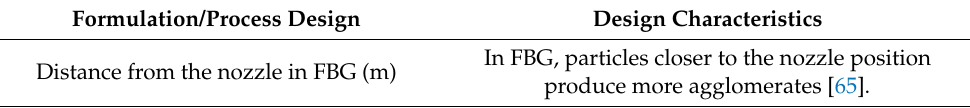
Table 5. General process design targeting granule growth and consolidation regimes for low-shear wet granulation processes (focus on fluid bed